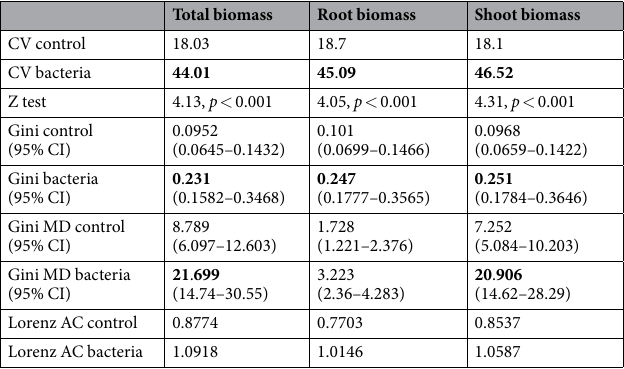
Table 1. Measures of inequality for calabrese plants grown in controlled conditions, with and without the addition of PGPR. CV is Coefficient of Variation, Gini is Gini Coefficient, Gini MD is Gini Mean of Differences and Lorenz AC is Lorenz Asymmetry Coefficient. Differences between bacterial treatments and the control are indicated in bold text. Differences in Gini Coefficients and Gini MD determined by non-overlap of confidence intervals at p = 0.05.